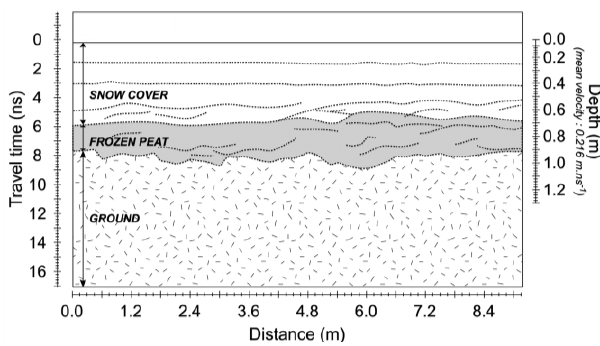
Figure 10. An interpretation of a high-frequency (900 MHz) GPR reflection profile at the open coniferous forest site (FII), 24 March